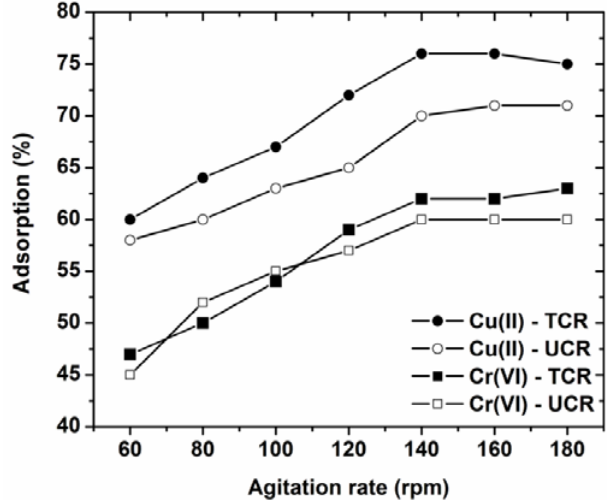
Figure 5. Effect of agitation rate on adsorption of Cu(II) and Cr(VI) onto treated and untreated coffee residues (pH = 5, 50 mg/L ion concentration, 1 g/L adsorbent, T = 25 °C, 60–180 rpm, 24 h contact).